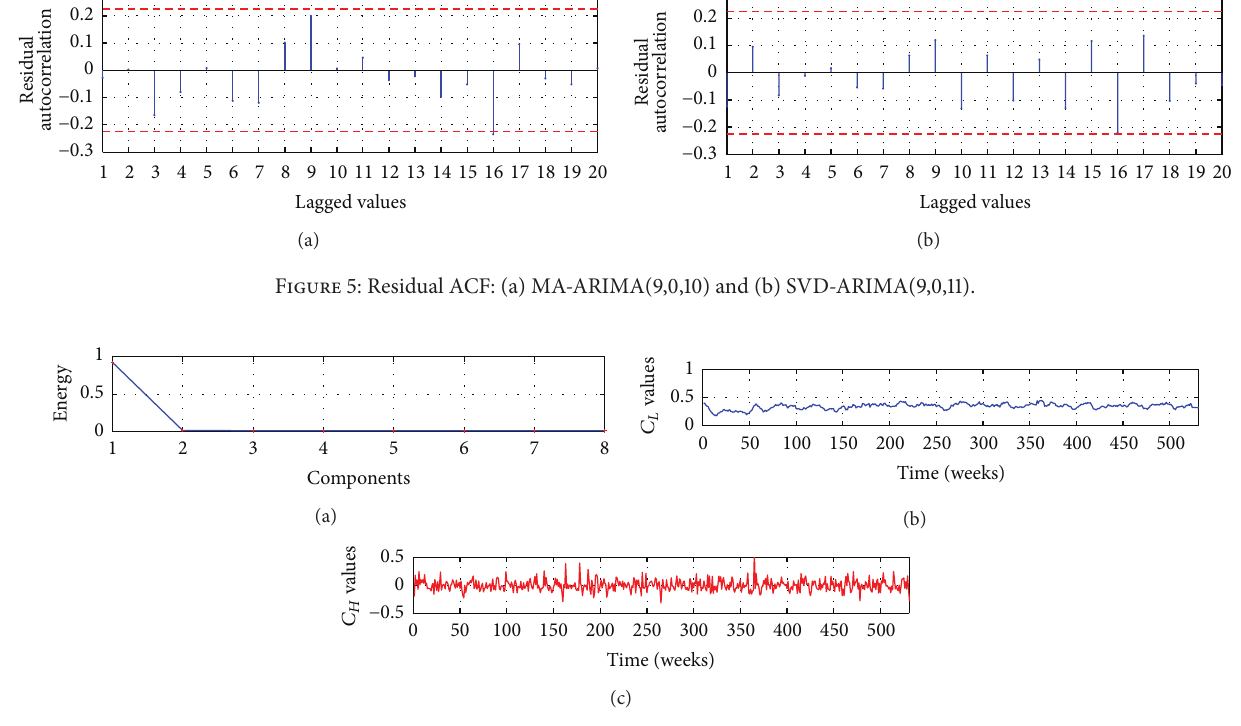
Figure 6: Accidents time series: (a) components energy, (b) low frequency component, and (c) high frequency component.